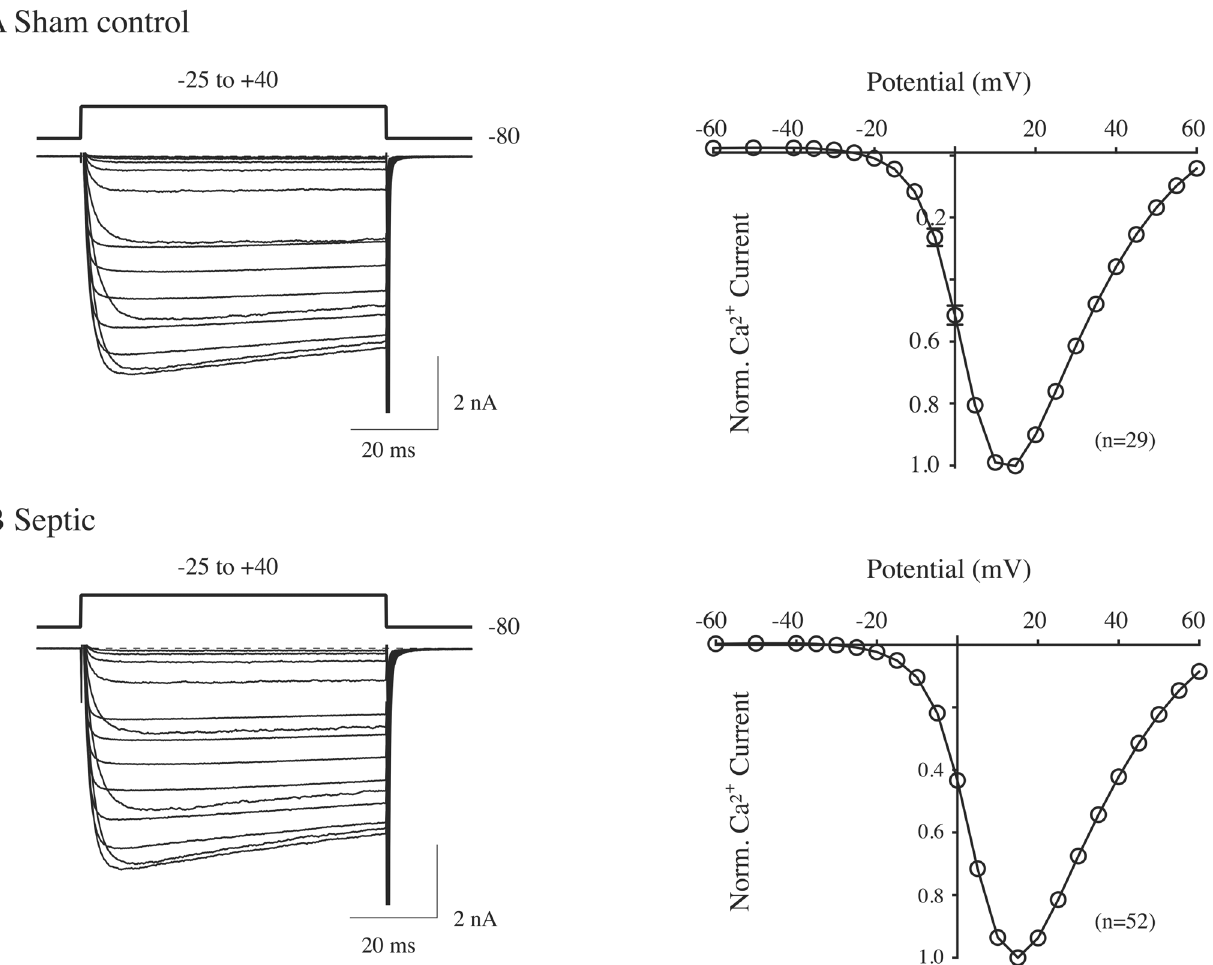
Fig 1. Normalized current-voltage (I-V) relationships of acutely isolated CSMG neurons from sham control (A) and septic (B) rats 48 hr post-sepsis induction by CLP. The I-V curves represent the mean Ca 2+ current amplitude for each test potential. Ca 2+ currents were evoked every 3 s with a 70 ms pulse from a holding potential of -80 mV to test potential between -60 and +60 mV. The current amplitude was measured 10 ms following the onset of the test pulse and normalized to +15 mV. The superimposed Ca 2+ current traces shown to the left were evoked to potentials from -25 to +40 mV. The number of neurons tested for each group is shown in